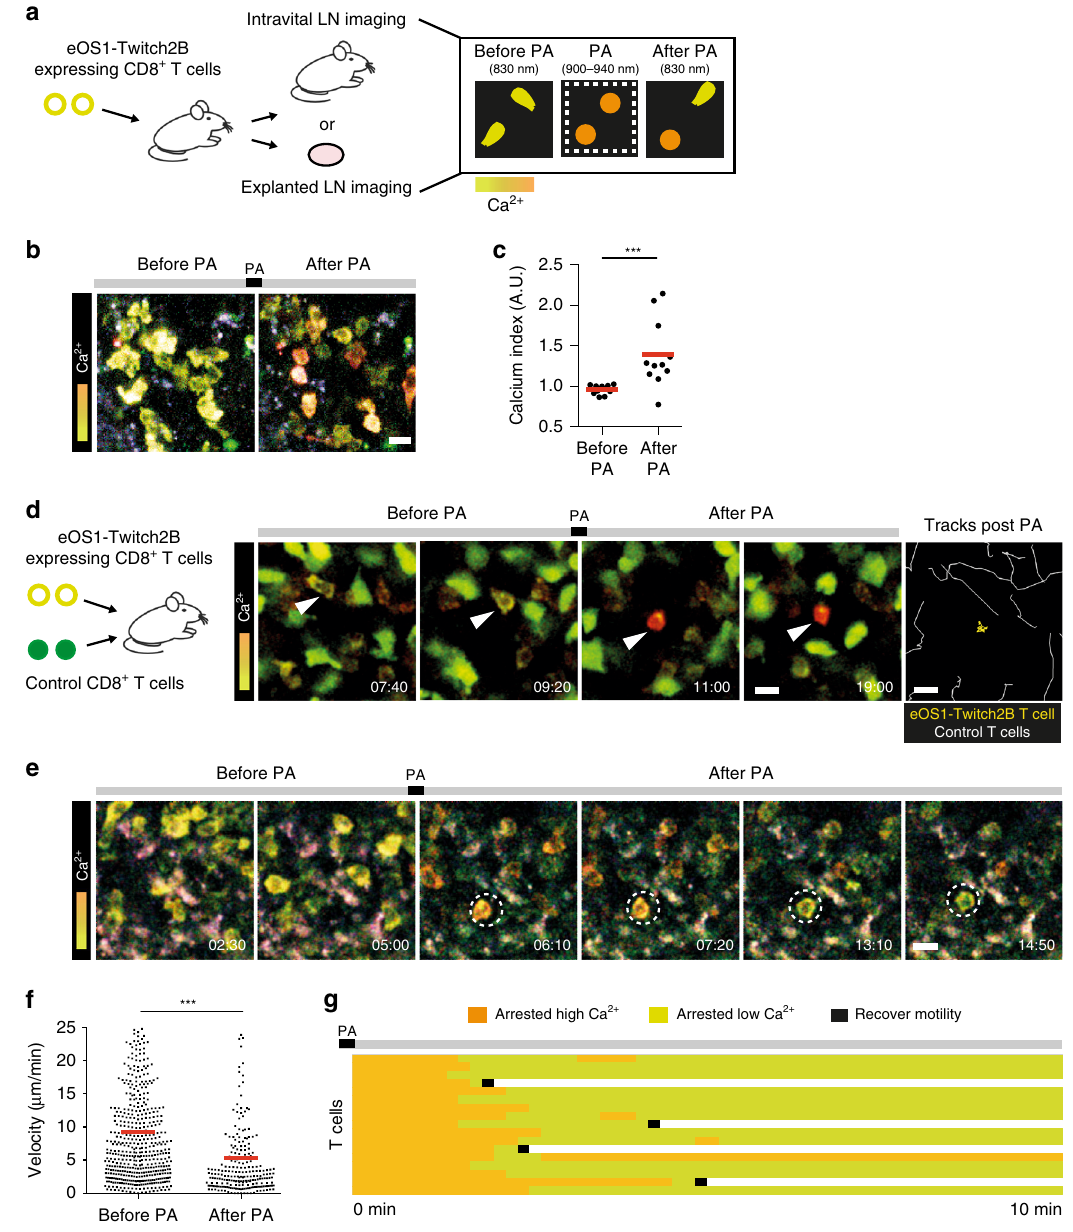
Fig. 5 Simultaneous imaging and manipulation of calcium signals in individual T cells in lymph nodes. a Experimental setup for optogenetic manipulation of T cells in lymph nodes. b – g CD8 + T cells expressing the eOS1 actuator and the Twitch2B calcium indicator were adoptively transferred. After 1 – 5 days, intravital imaging of the popliteal lymph node or explanted lymph node imaging was performed using two-photon microscopy. b , c Time-lapse images b and quanti fi cation c showing calcium levels (Twitch2B signals, YFP:CFP ratio) in T cells before and after photoactivation during intravital imaging. Photoactivation was performed by tuning the laser at 900 nm with the laser power set at 25%, using the resonant scanner (0.067 µ s/pixel). Scale bar: 10 µ m. Each dot represents one cell. Bars represent mean values. Statistical signi fi cance was assessed using a two-tailed Mann – Whitney test (*** p < 0.001). d eOS1-expressing T cells but not control T cells react to two-photon photoactivation. CD8 + T cells expressing the eOS1 actuator and the Twitch2B calcium indicator were adoptively transferred together with CFP-expressing control T cells. After photoactivation in explanted lymph nodes, eOS1-expressing T cells (yellow cells) arrested while control T cells (green cells) maintained their motile behavior. Photoactivation was performed at 900 nm with the laser power set at 30% using the resonant scanner (0.067 µ s/pixel). Scale bar: 10 µ m. Times are in min:sec. White arrows show an eOS1- expressing T cell. Representative of fi ve independent experiments. e Calcium signals can promote prolonged arrest in T cells. Time-lapse images show that two-photon photoactivation elicits a transient calcium elevation and T cell arrest in explanted lymph nodes. Dotted circles highlight one T cell over time. Photoactivation was performed at 900 nm with the laser power set at 30% using the resonant scanner (0.067 µ s/pixel). Scale bar: 10 µ m. Times are in min:sec. Representative of fi ve independent experiments. f Quanti fi cation of T cell velocities before or just after photoactivation. Each dot represents one cell. Bars represent mean values. Statistical signi fi cance was assessed using a two-tailed Mann – Whitney test (*** p < 0.001). g Calcium signals can promote prolonged T cell arrest. The fi gure compiles the fate of individual T cells after photoactivation. Each line represents a cell. Note that after a few minutes, calcium levels return to baseline levels but many T cells remain arrested. Source data are provided as a Source Data